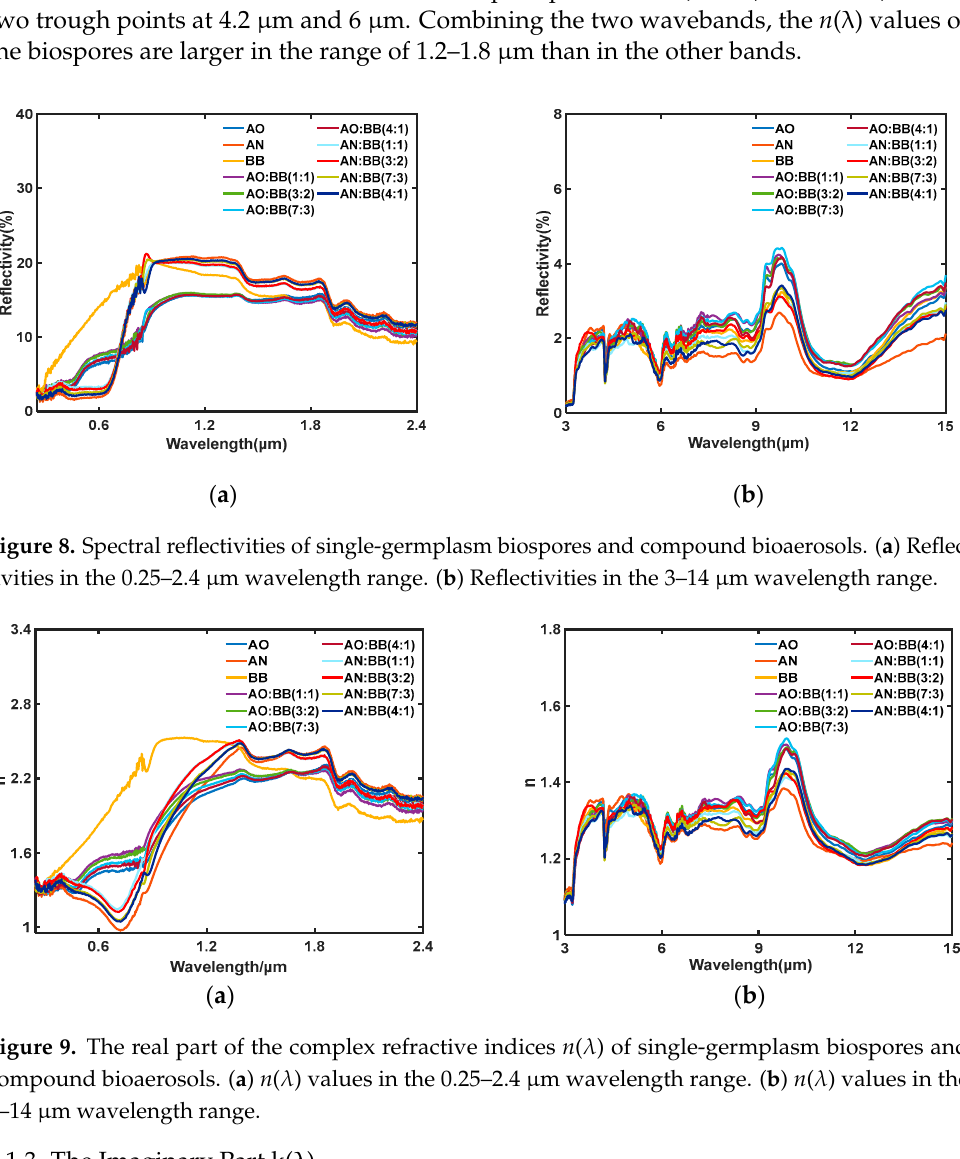
Figure 8. Spectral reflectivities of single-germplasm biospores and compound bioaerosols. ( a ) Re- flectivities in the 0.25–2.4 μ m wavelength range. ( b ) Reflectivities in the 3–14 μ m wavelength range.